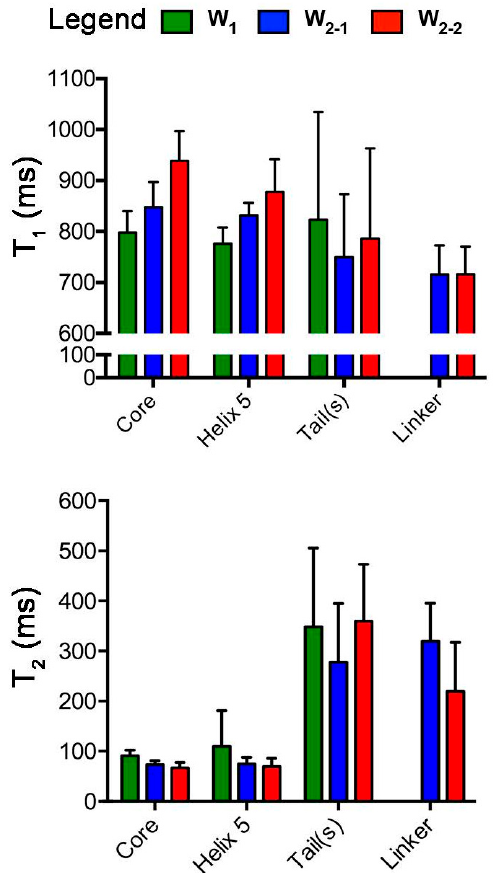
Figure 2. Bar graphs representing the mean T 1 and T 2 (error bars: standard deviations) for key regions of the W unit. These were specifically defined as the core (residues 12–149 (W 1 , W 2-1 ) and 212–349 (W 2-2 )), linker (residues 150–211 from W 2-1 and W 2-2 ), tails (W 1 : residues 1–11 and 150–199; W 2 : residues 1–11 and 350–400), and helix 5 (residues 135–149 (W 1 , W 2-1 ) and 335–349 (W 2-2 )).